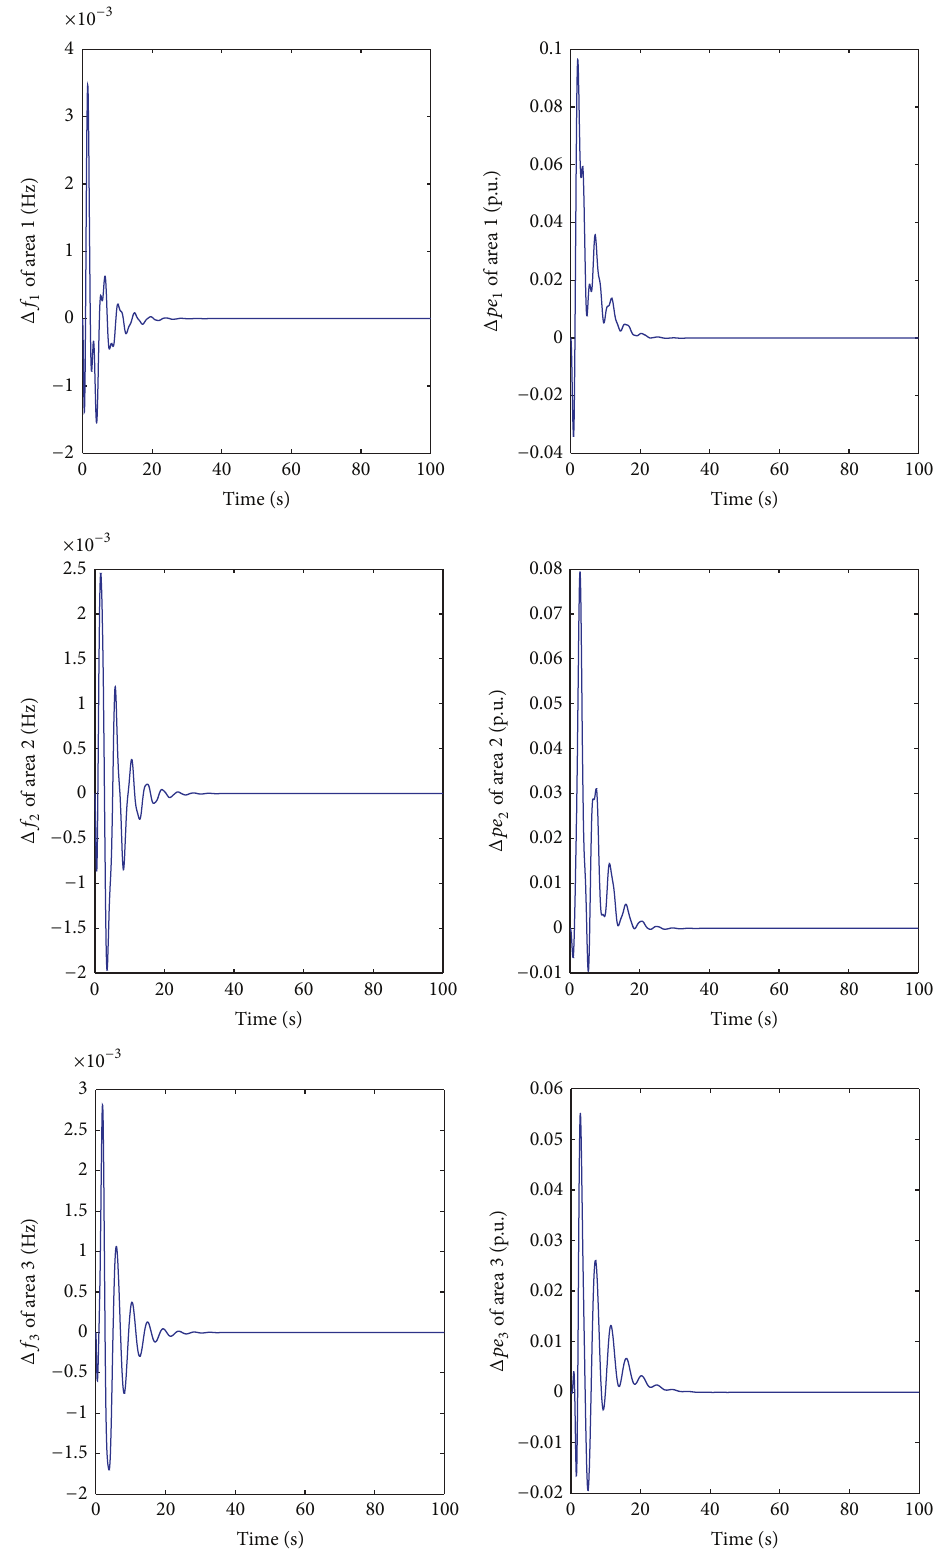
Figure 5: Step load disturbance responses of the original subsystems and the newly added